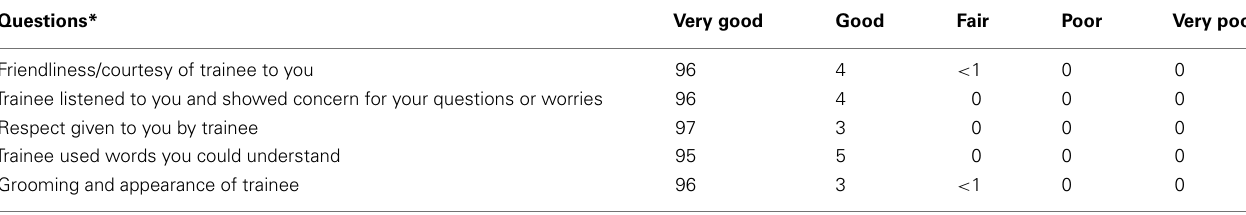
Table 1 | Communication/professionalism training questionnaire summary of 742 forms.